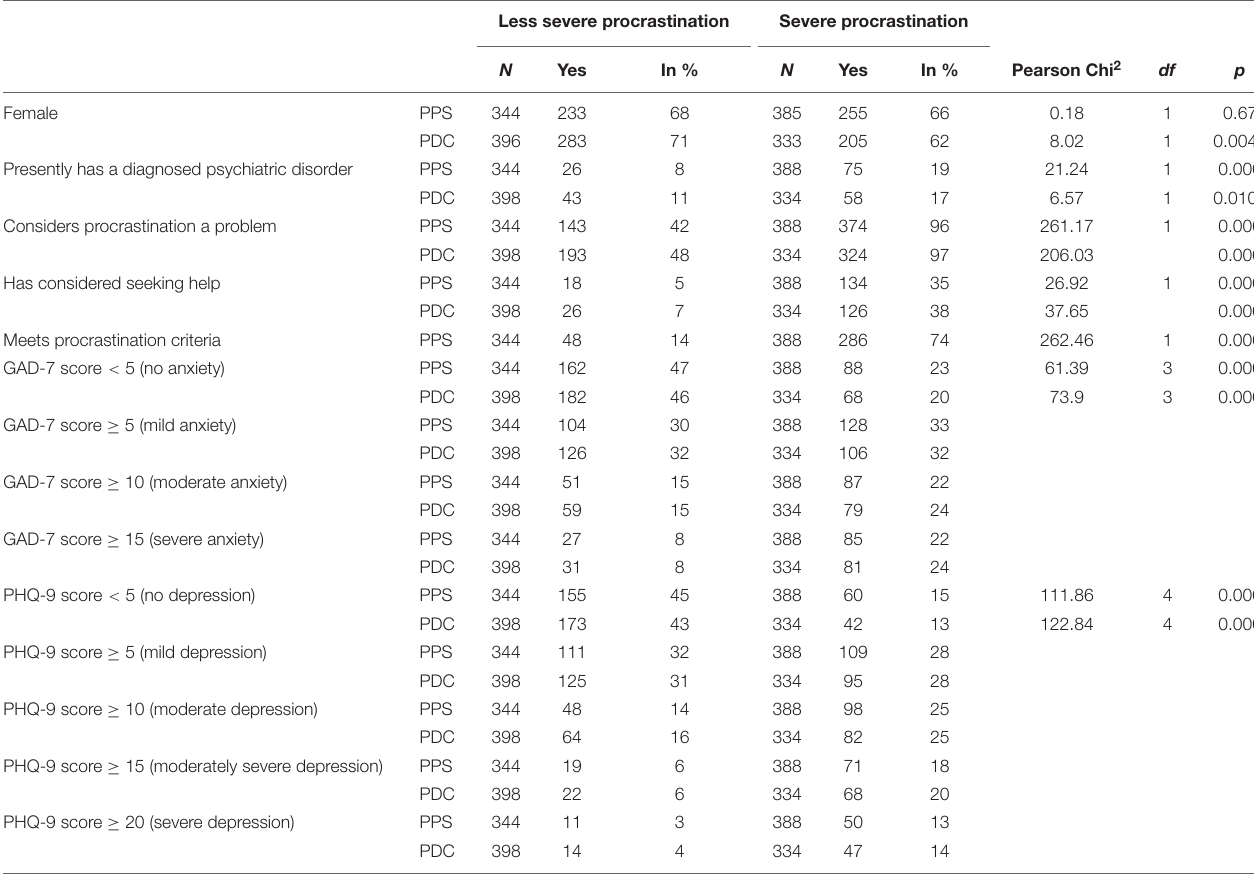
TABLE 2 | Differentiating severe procrastination from less severe